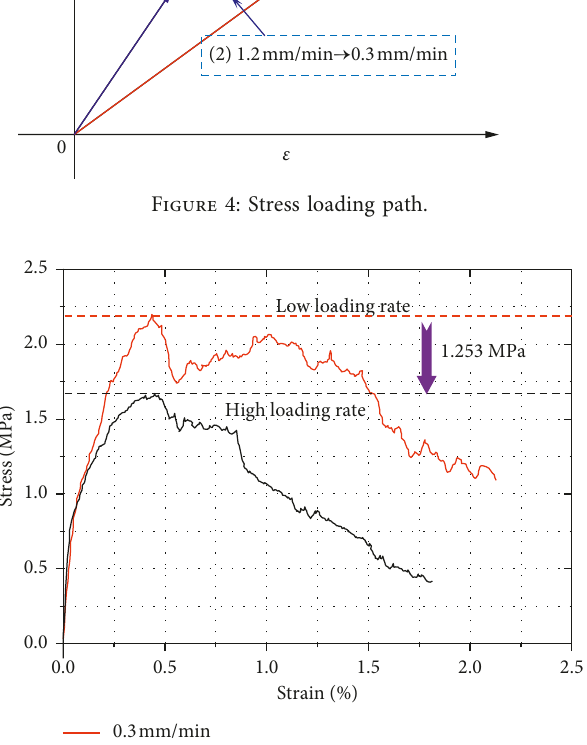
Figure 5: Stress-strain curves of the RCB(0) specimen under constant loading rate.